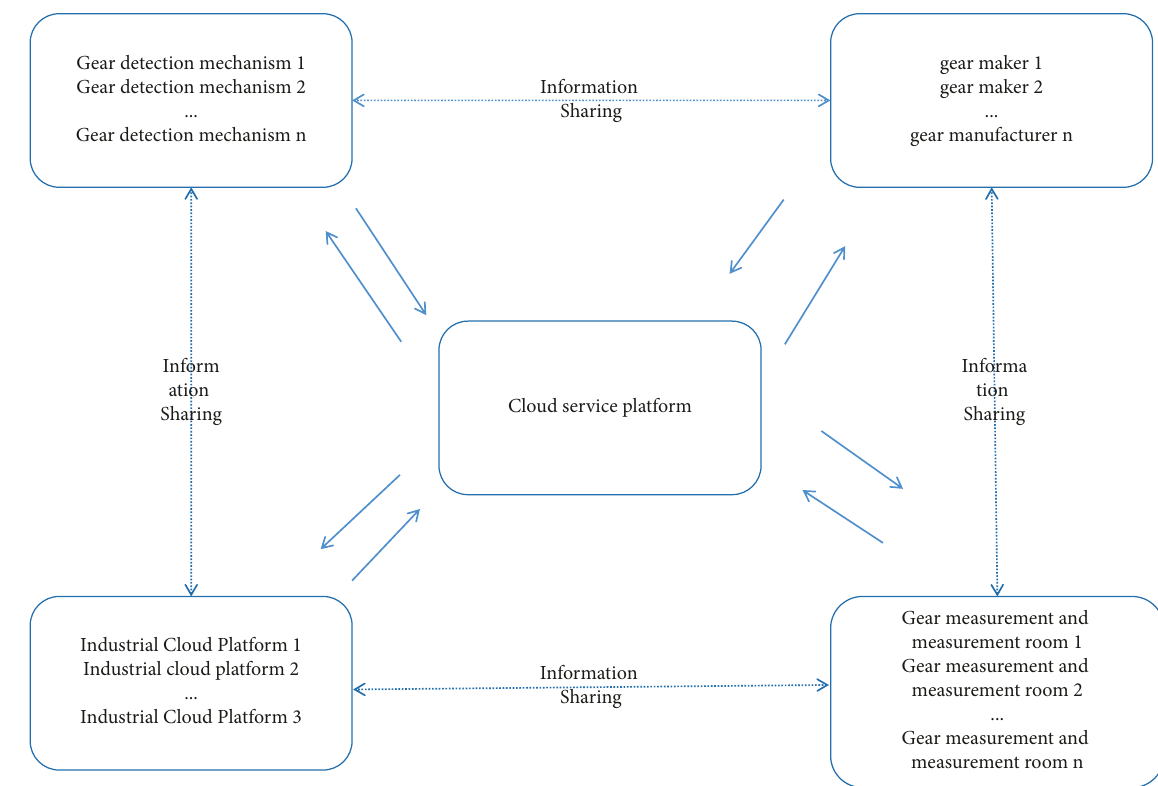
Figure 7: Geometric